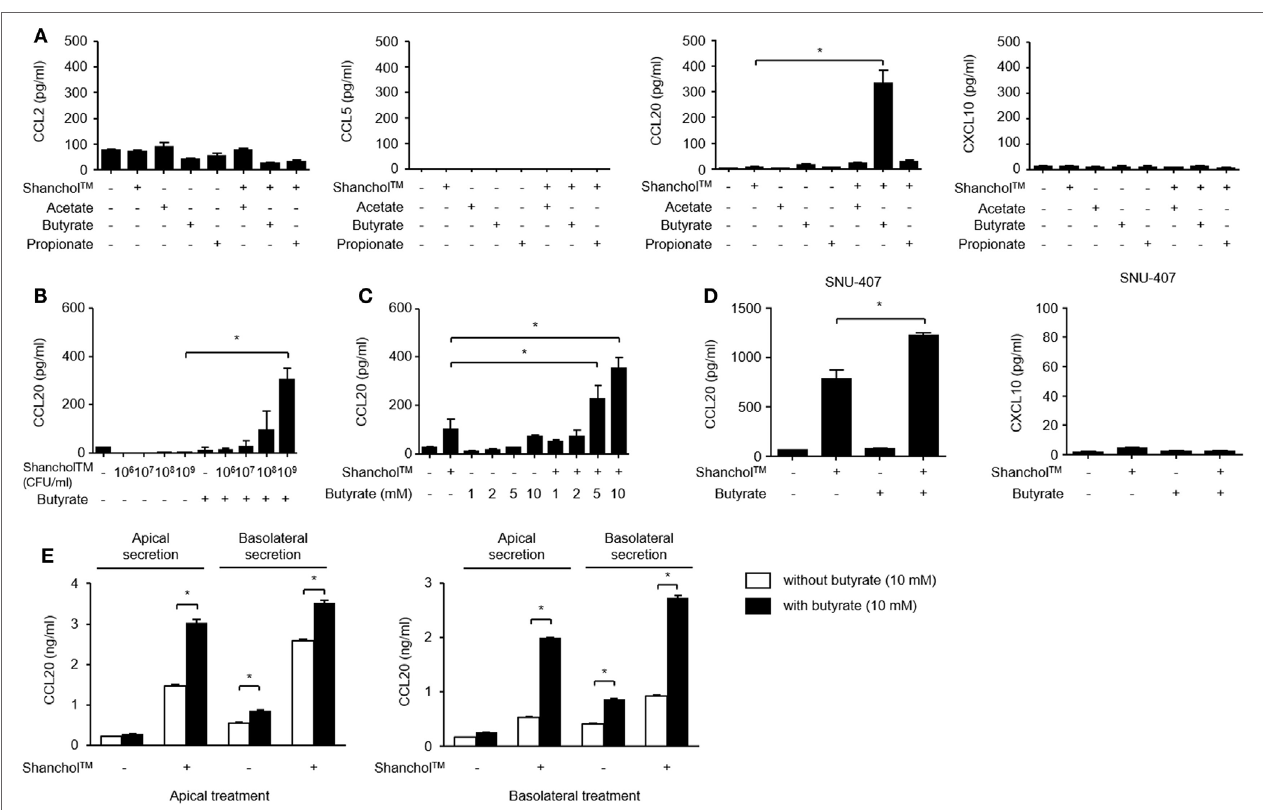
FigUre 2 | Shanchol ™ significantly induces CCL20 secretion in the presence of butyrate in Caco-2 cells. (a) Caco-2 cells were stimulated with Shanchol ™ (10 9 CFU/ml) in the presence or absence of acetate, butyrate, or propionate (10 mM). (B,c) Caco-2 cells were incubated with various concentrations of Shanchol ™ (10 6 –10 9 CFU/ml) in the presence of butyrate (10 mM) (B) or with various concentrations of butyrate (1–10 mM) in the presence of Shanchol ™ (10 9 CFU/ml) (c) for 24 h. (D) SNU-407 cells were stimulated with Shanchol ™ (10 9 CFU/ml) in the presence or absence of 10 mM butyrate for 24 h. (e) Caco-2 cells were plated on Transwell ® supports for 4 weeks and then apically or basolaterally treated with Shanchol ™ (10 9 CFU/ml) and/or butyrate (10 mM). The culture supernatants in the apical and basolateral compartments were then collected. The concentrations of secreted CCL2, CCL5, CCL20, and CXCL10 were measured in the culture supernatants by ELISA. N.D., not detected. All results are expressed as mean ± SD of triplicate samples. The asterisk (*) indicates a statistically significant difference ( P < 0.05) compared with the appropriate